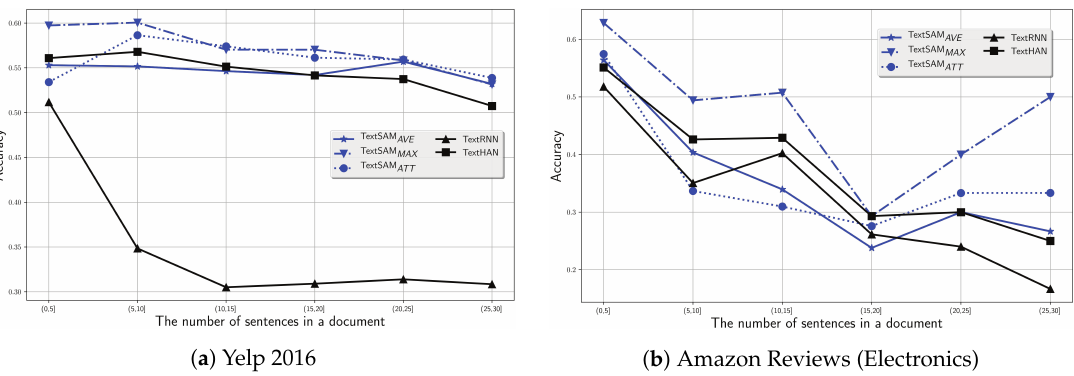
Figure 5. Classification accuracy on documents with various number of sentences.